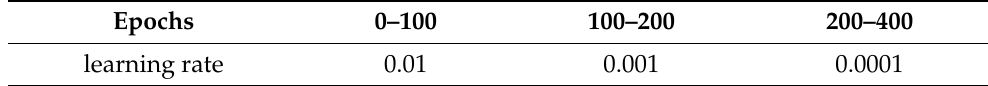
Table 2. Learning rate schedule for the